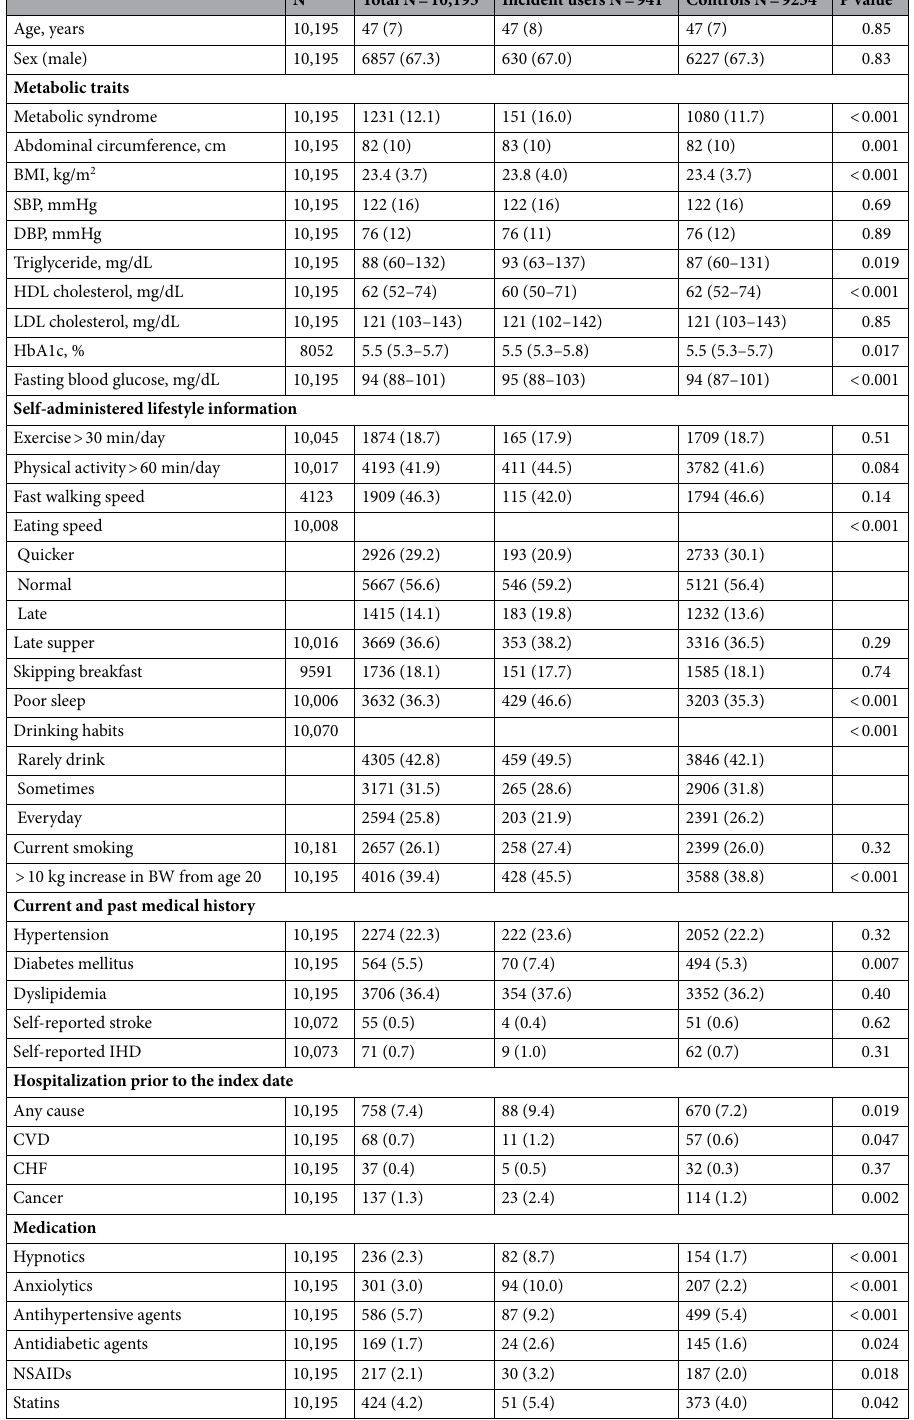
Table 2. Baseline characteristics of the risk-set sample. Data are expressed as N (%) for categorical values and mean (standard deviation) for continuous values. BMI body mass index, SBP systolic blood pressure, DBP diastolic blood pressure, HDL high-density lipoprotein, LDL low-density lipoprotein, BW body weight, IHD ischemic heart disease, CVD cardiovascular disease, CHF congestive heart failure, NSAIDs non-steroidal anti- inflammatory